Question: How would you classify this visualization?
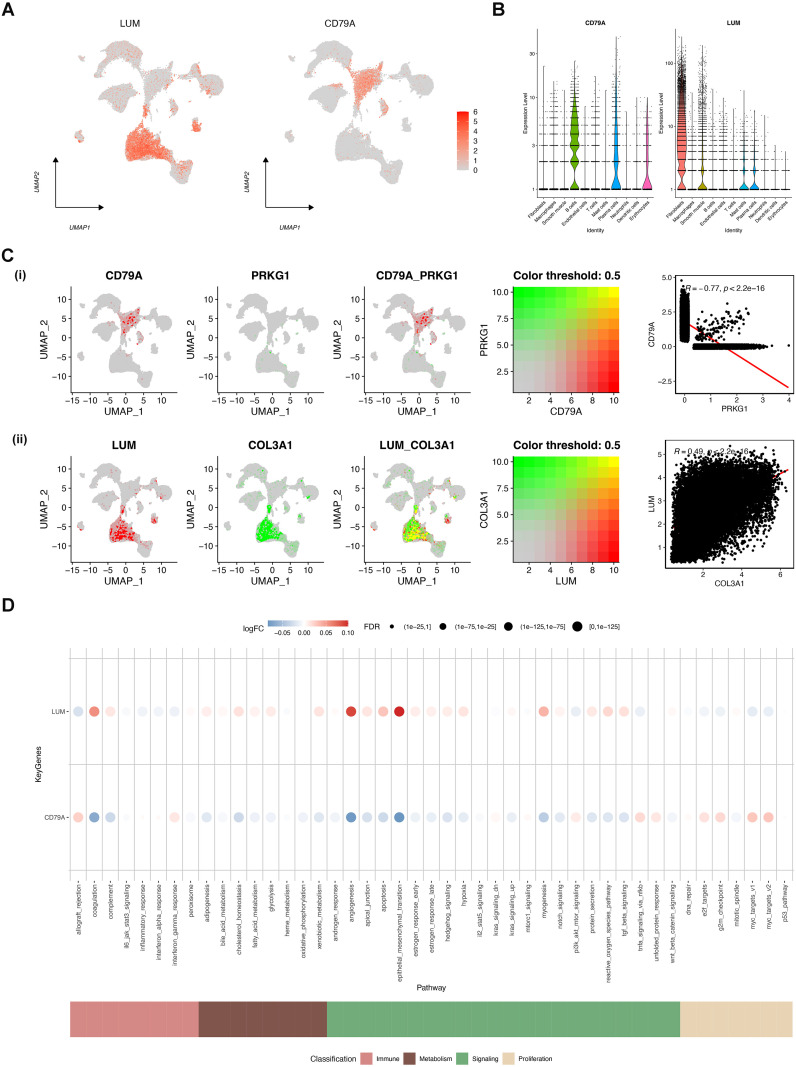
Answer: scatter